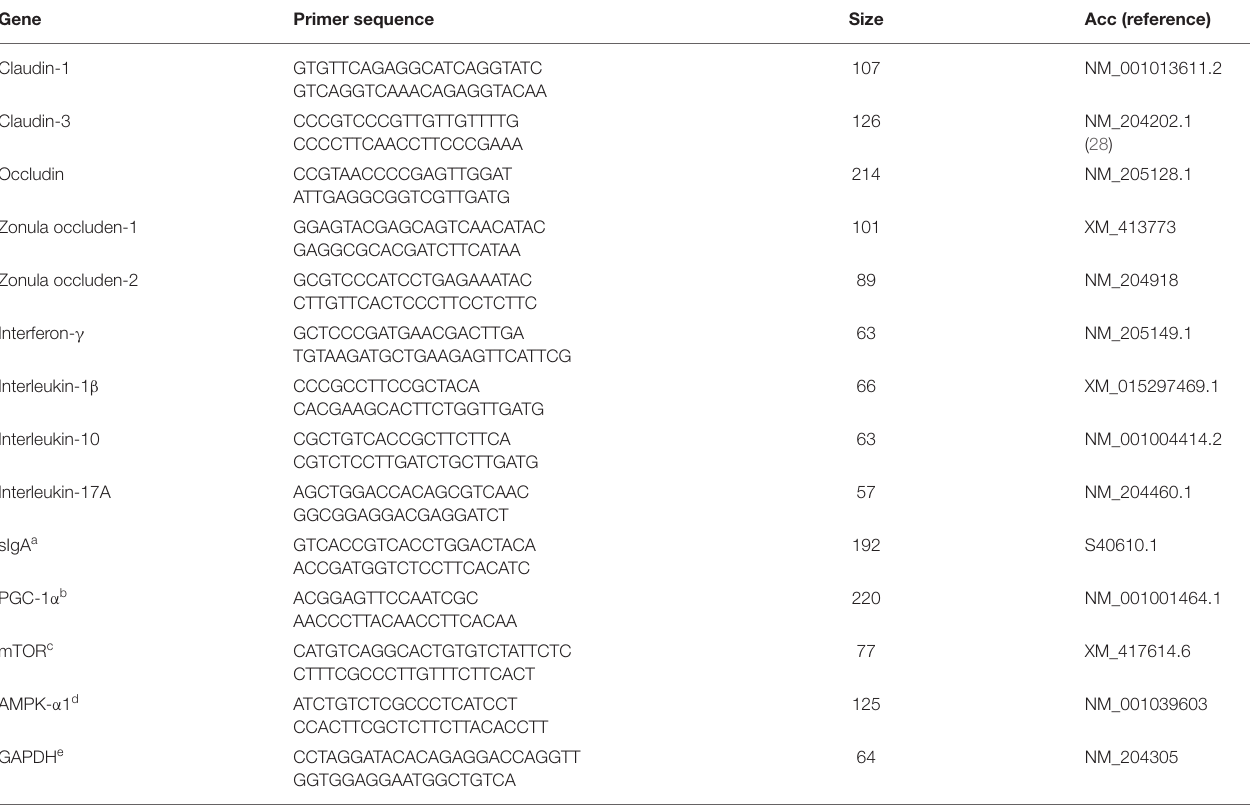
TABLE 2 | Sequences of primer pairs used for amplification of target and reference genes.